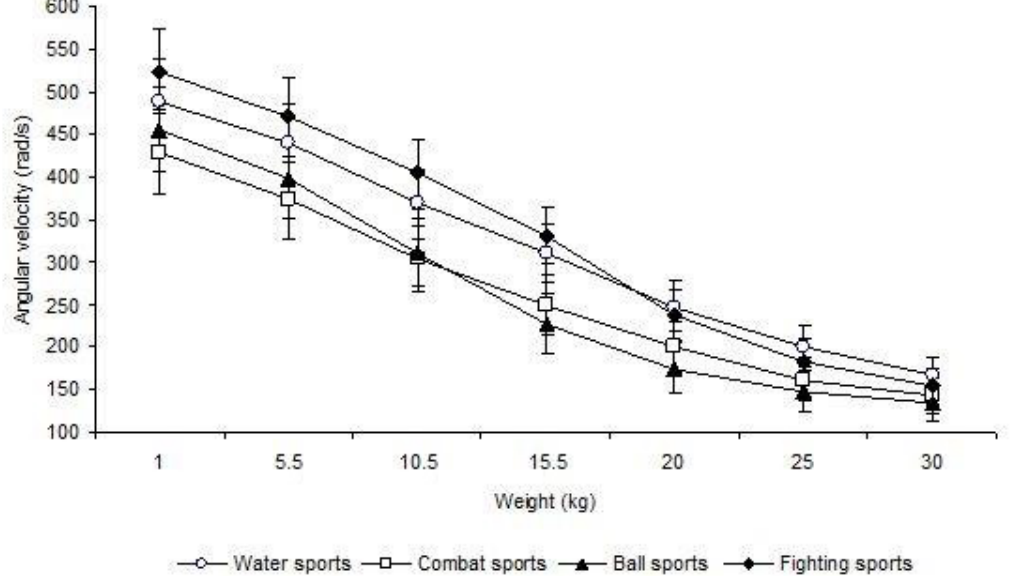
Figure 2. Angular velocity during trunk rotations across different weights in ball, combat, fighting and water sports athletes.